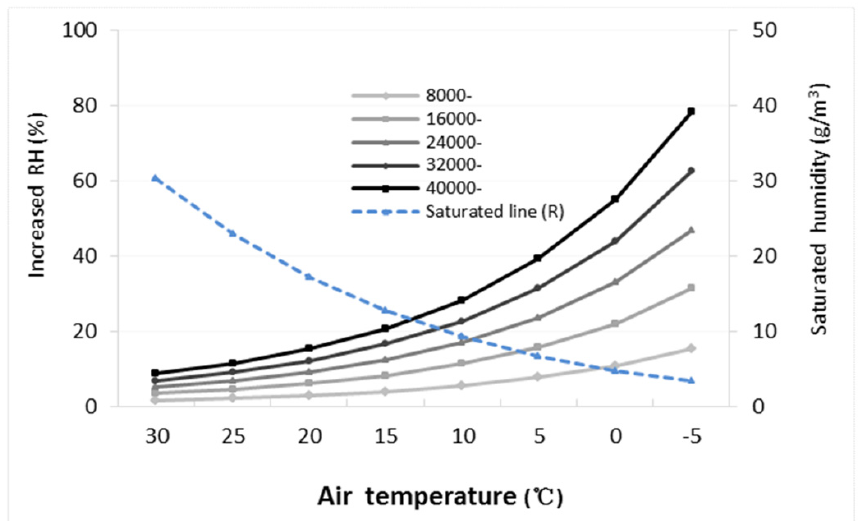
Figure 3. The increase in the relative humidity (RH) in the air after spraying water on roads for 5 days at different air temperatures. The RH varied between different quantities of water sprayed on the roads (DF = 4, F = 14.21, p < 0.0001), and between different air temperatures (DF = 7, F = 17.95,